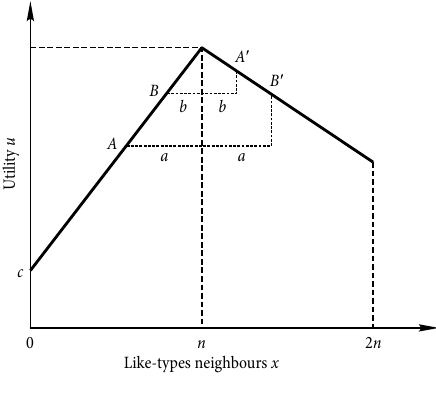
Fig. 4. Interchange of Type